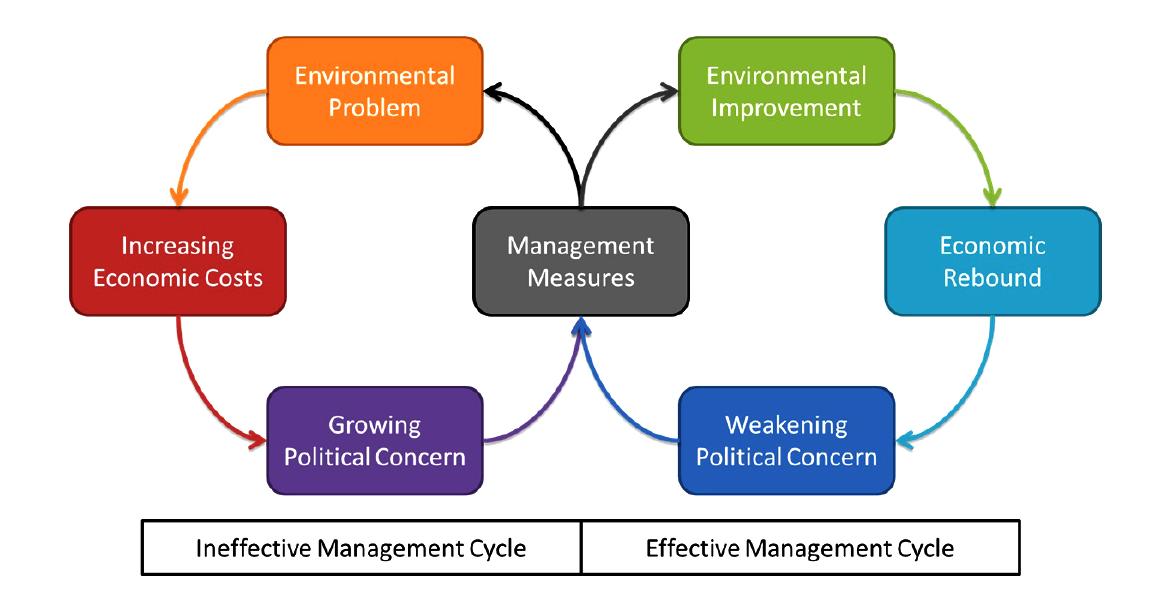
Fig. 1 . Responsive governance cycles.